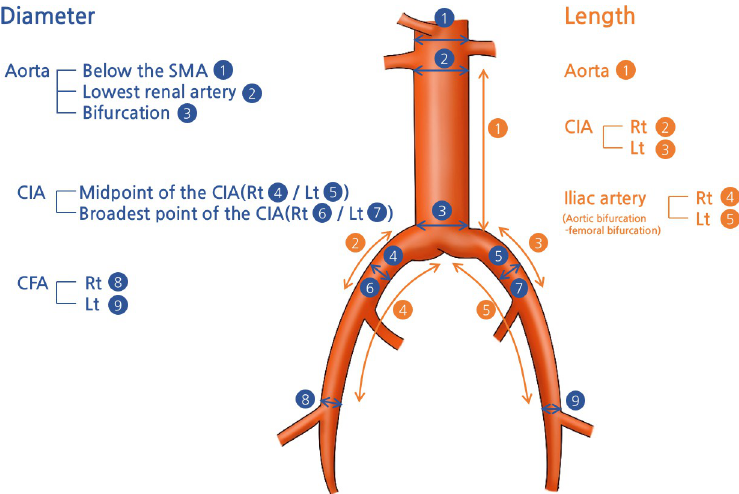
Fig 1. Diameter and length measurements at each site. SMA, superior mesenteric artery; CIA, common iliac artery; CFA, common femoral artery; Rt, right; Lt,